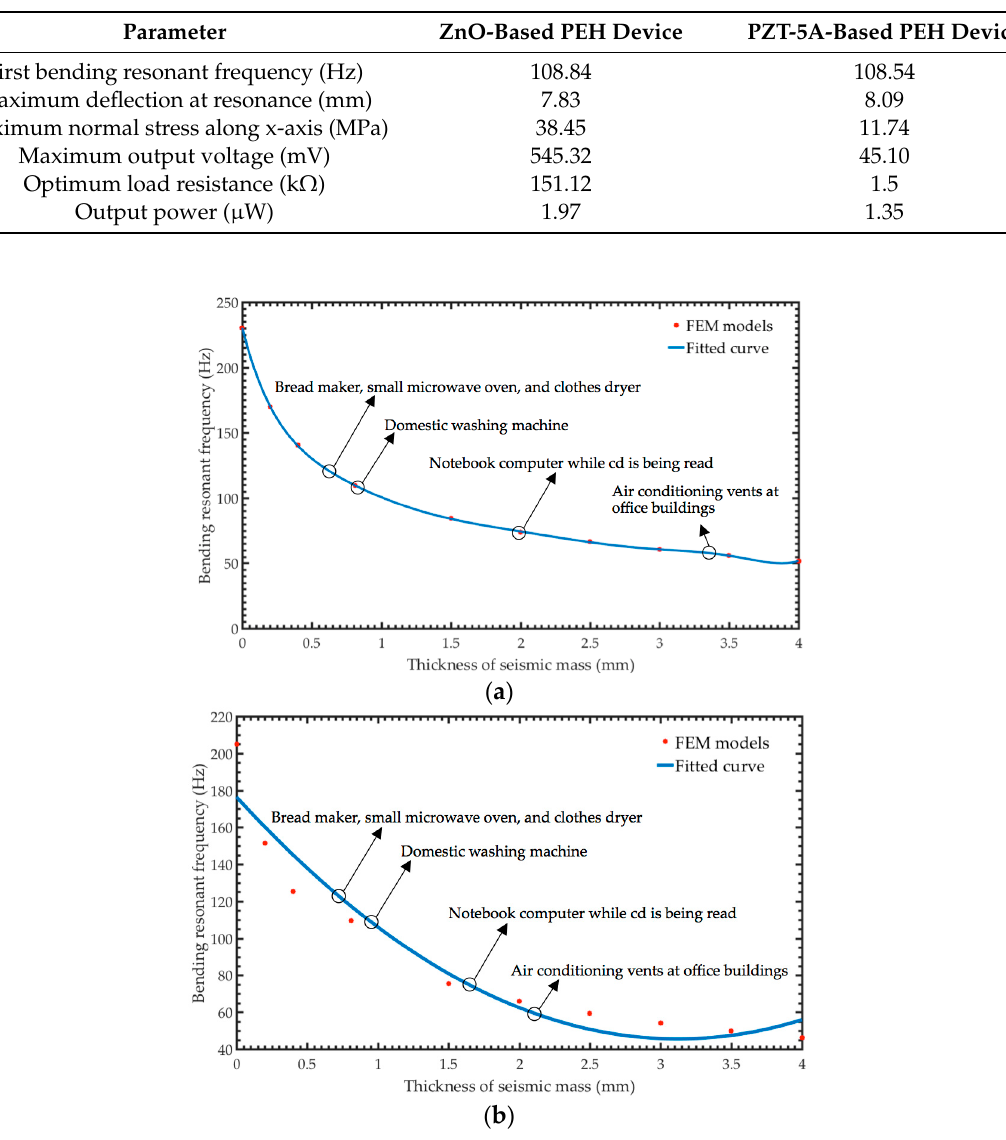
Figure 10. Variation of the first bending resonant frequency of PEH devices with ZnO ( a ) and PZT-5A ( b ) layers due to the shift of the thickness of the seismic mass. ( b ) layers due to the shift of the thickness of the seismic